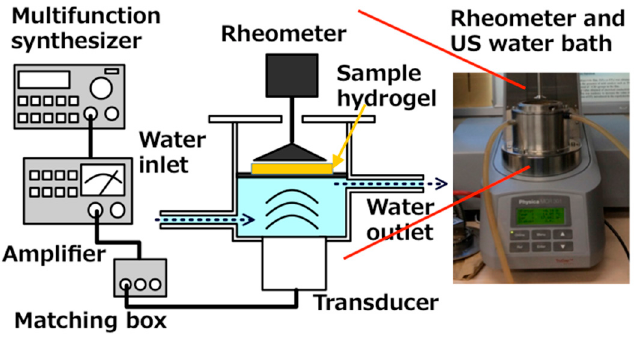
Figure 6. Schematic drawing US water bath for equipment to rheometer.